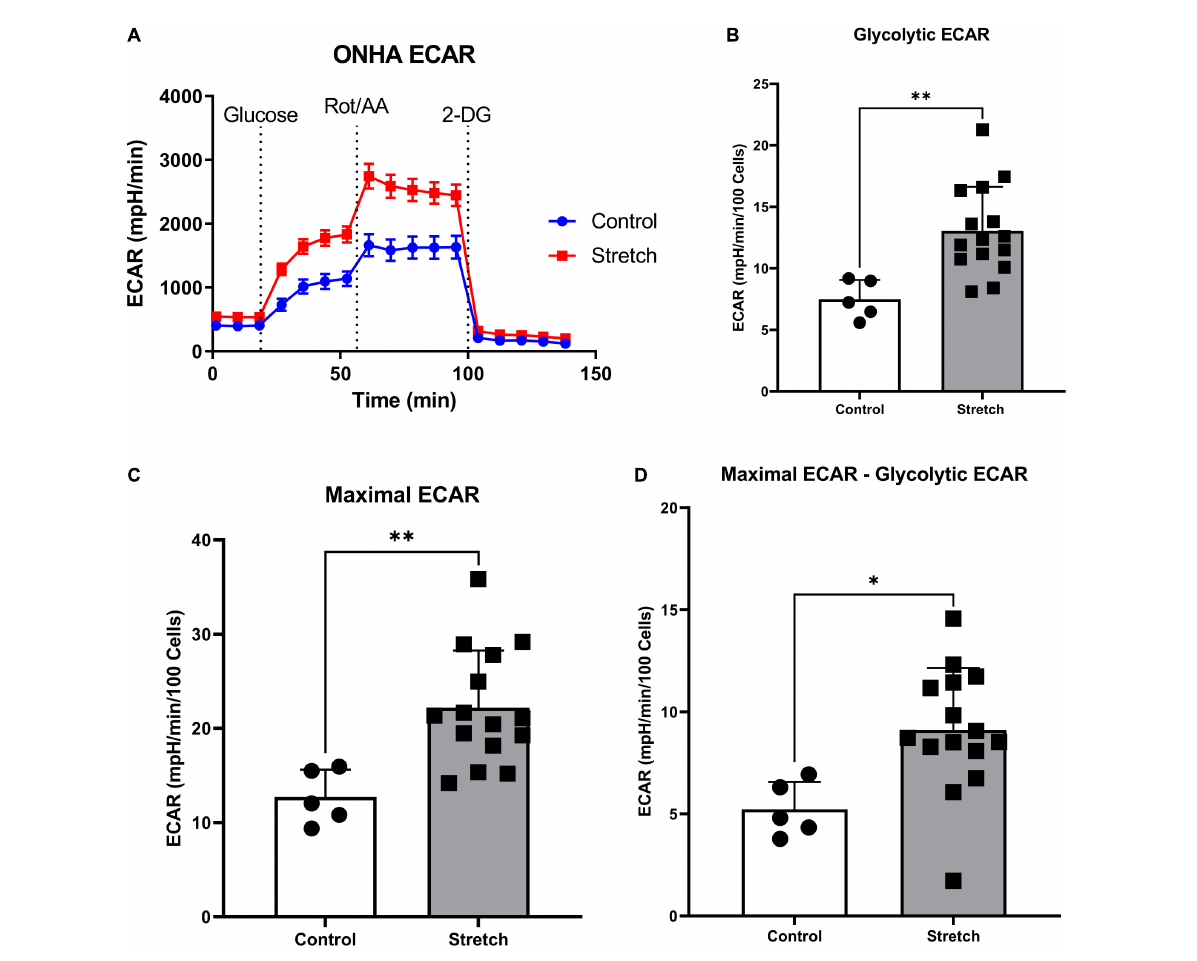
FIGURE2 Glaucoma-like stretch causes an increase in glycolytic activity in primary optic nerve head astrocytes (ONHAs). (A) Stretch increases the extracellular acidification rate (ECAR) of primary ONH astrocytes. Measurements were taken every 9 min for baseline OCR, then addition of glucose, rotenone with Antimycin-A, and 2-deoxyglucose (2-DG). (B) Following the addition of glucose, stretched ONH astrocytes have a significantly higher ECAR than control ONH astrocytes (** p = 0.0037, n = 20). (C) Stretched ONH astrocytes have a significantly higher maximal ECAR than control ONH astrocytes (** p = 0.0039, n = 20). (D) Stretched ONH astrocytes have a significantly higher ECAR upregulation following the addition of rotenone and Antimycin-A compared to control ONH astrocytes (* p = 0.0136, n = 20). Values for panels (B–D) are normalized to cell